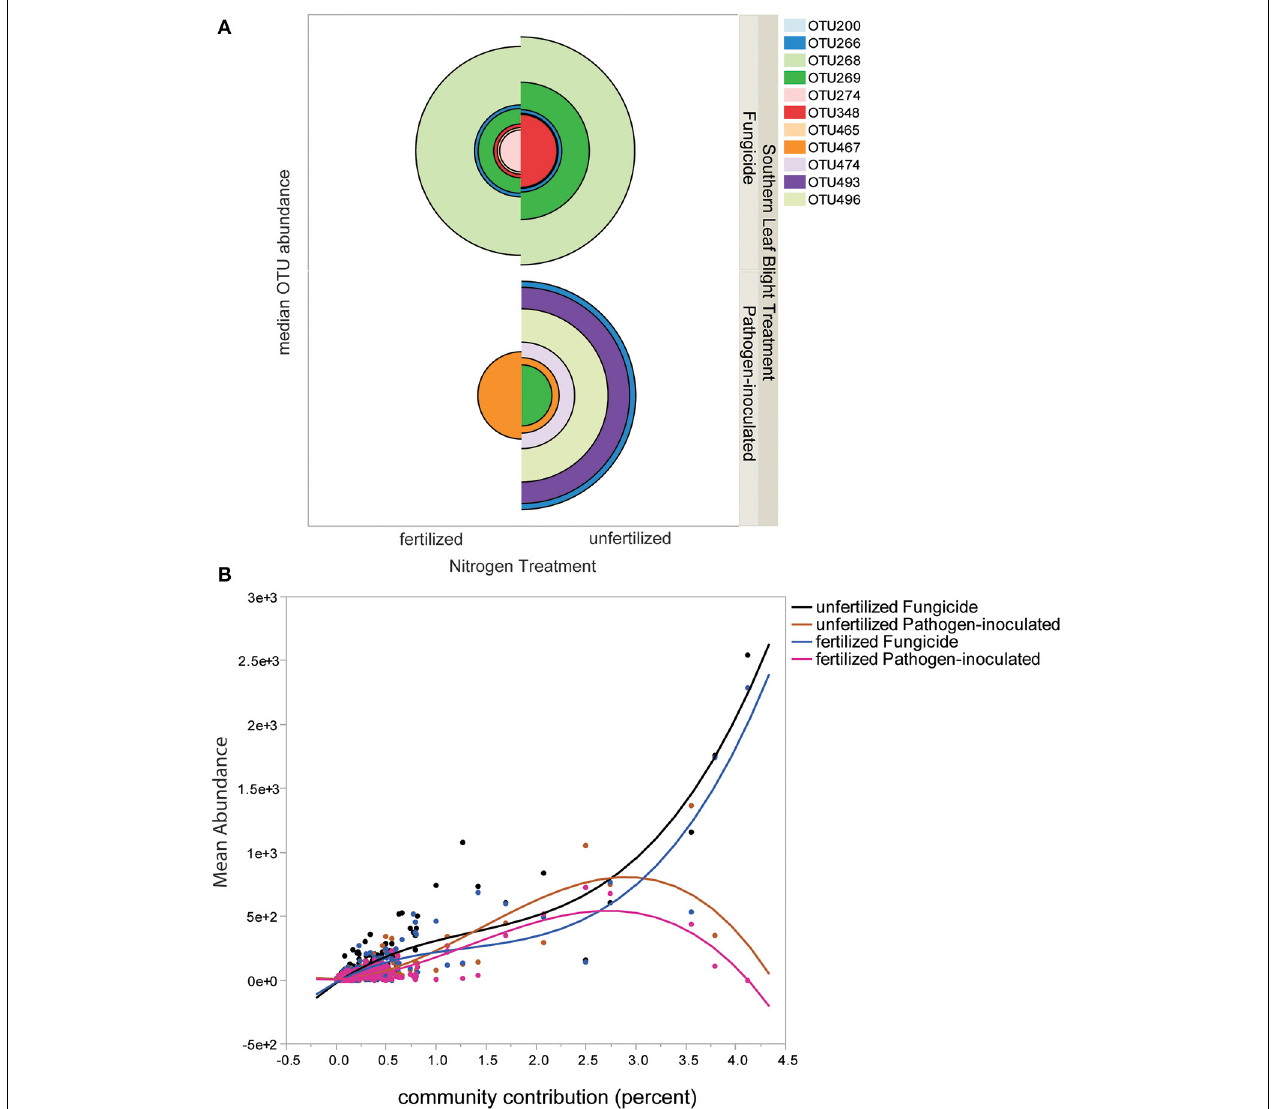
FIGURE 2 | Distribution of individual ribotypes in each treatment level. (A) Twelve OTU contributing more than two percent to treatment level differences by SIMPER analysis are shown, with the size of the pie chart segment indicating the median relative abundance of the OTU. Each OTU is identified by the ribotype size number in parentheses, and the size of the quadrant for each is the median abundance of the ribotype in that sample. (B) Plot of OTU abundances ordered by